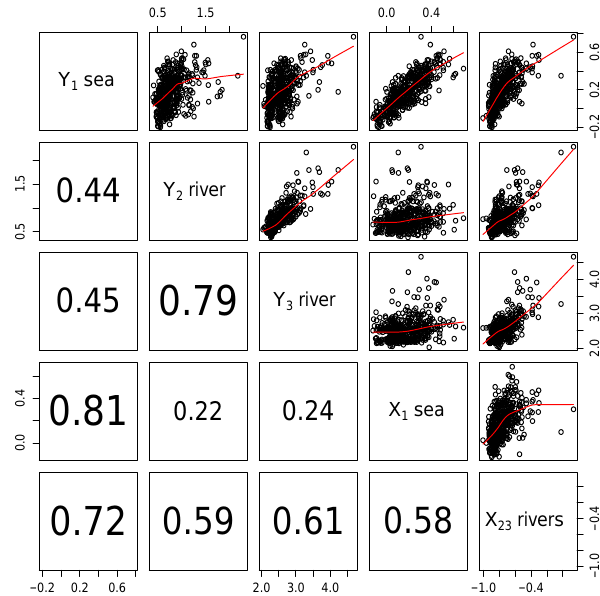
Figure 4. Scatter plots of predictands Y obs and predictors X obs . The numbers are Spearman coefficient correlations. The red lines (computed via LOWESS, i.e. locally weighted scatter-plot smooth- ing) are shown to better visualize the relationship between pairs (R Core Team,